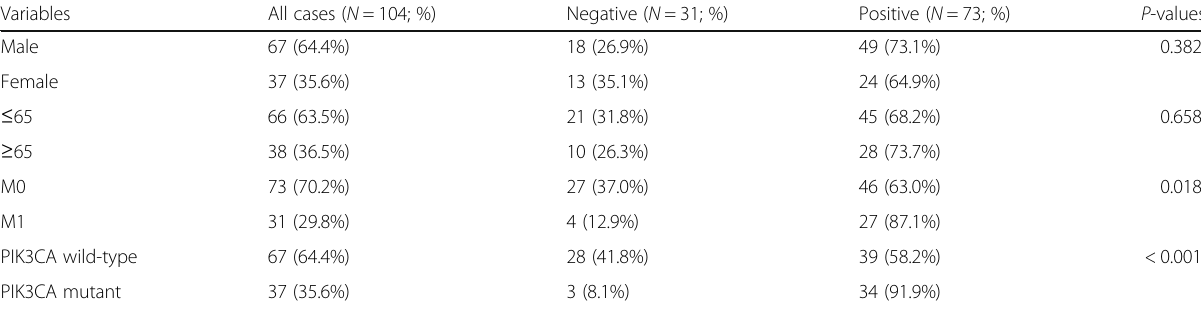
Table 2 Clinicopathological variables of 104 CRC patients and their correlation with PI3K (p110 α ) expression Variables